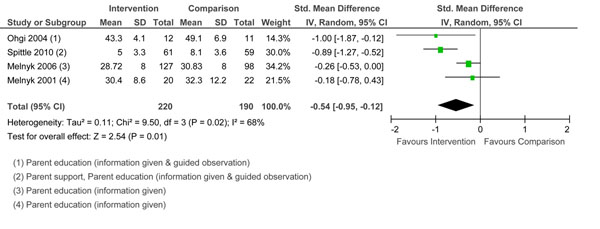
Forest plot of comparison: 1 Group, outcome: 1.3 Anxiety.